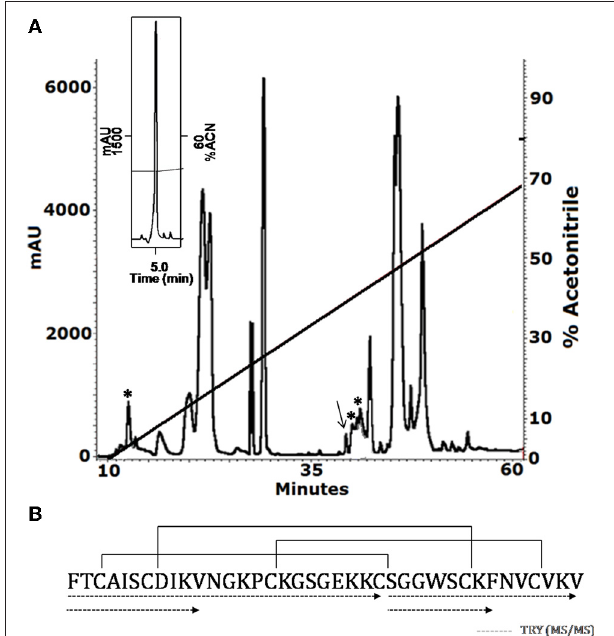
FIGURE 2 | Purification and covalent structure of Juruin. (A) 2.5mg of soluble venom from A. juruensis was separated by HPLC using a C18 reverse-phase column, eluted with a linear gradient from solution A to 80% solution B run for 50min. The fractions labeled with the asterisk exhibited antimicrobial activity and were eluted at 11.2, 40.6, and 42.0min, respectively. The fraction labeled with an arrow was eluted at 40.0min, and was rechromatographed in the same system and run from 30% to 40% solution B in 60min (inset). The major component is pure Juruin. (B) Complete amino acid sequence of Juruin was obtained by mass spectrometry fragmentation of several peptides obtained by enzymatic hydrolysis of Juruin, as indicated by the segments underlined by dotted lines. Solid lines linking the cysteine residues indicate the disulfide bridges in positions Cys 3 to Cys 24 , Cys 7 to Cys 30 , and Cys 15 to Cys 35 . The N-terminal phenylalanine and the C-terminal amidated valine were determined by mass spectrometry (MS/MS)